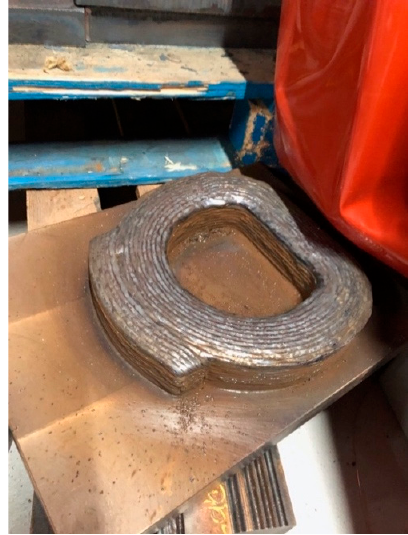
Figure 10. Crane hook during the 3D printing process.